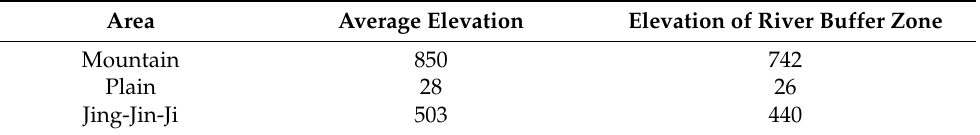
Table 1. The comparison of average elevation and elevation of river buffer zone